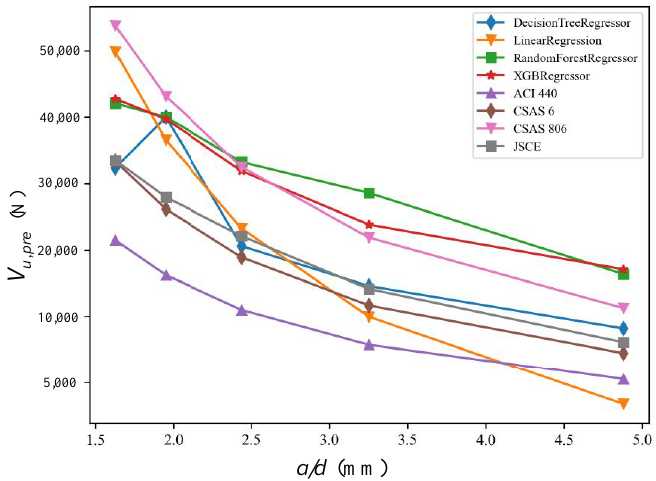
Figure 12. Effects of the shear span-depth ratio on shear performance. Figure 13 shows that the shear strength predictions vary with increasing concrete strengths from 25 MPa to 60 MPa. As shown in Table 1, the predictions of the codified design provisions are related to √𝑓 𝑐′ or √𝑓 𝑐′ 3 . The XGBoost model and JSCE predictions show a similar curve slope related to √𝑓 𝑐′ 3 . With nonlinear relations between 𝑓 𝑐′ and the shear predictions, the Linear Regression model is more sensitive to the increasing 𝑓 𝑐 ′ than to the remaining prediction curves. The curve slope of the Random Forest model is similar to that of the CSA S6 and ACI 440 but with higher predictions, although it does not show explicit relation with 𝑓 𝑐′ , and the validity of the prediction curve is still higher.